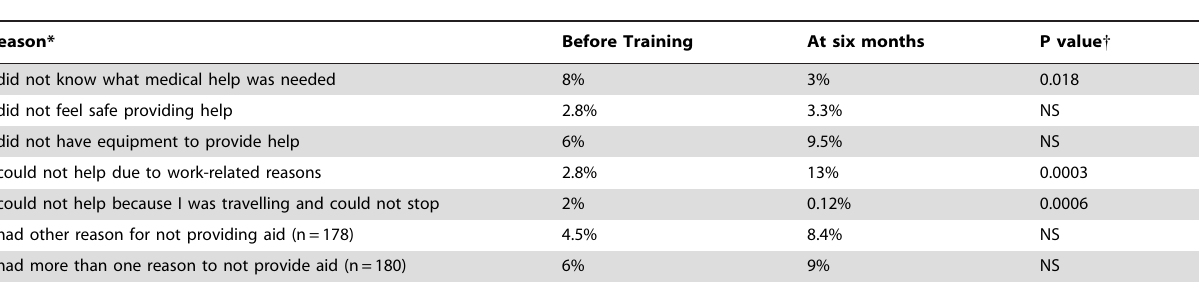
Table 3. Reported reasons for not providing